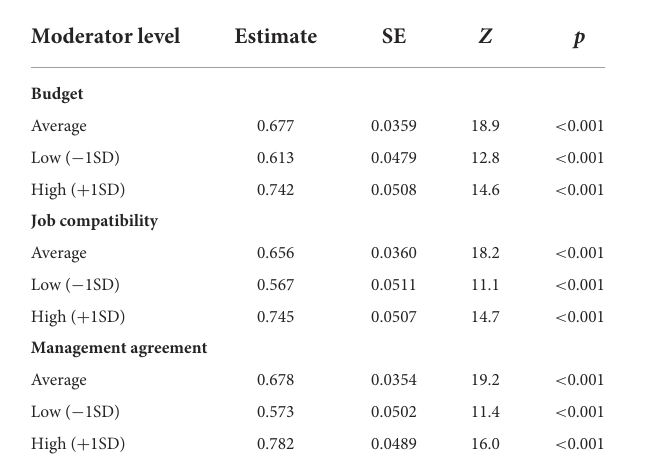
TABLE 6 Results of the single slope analyses.